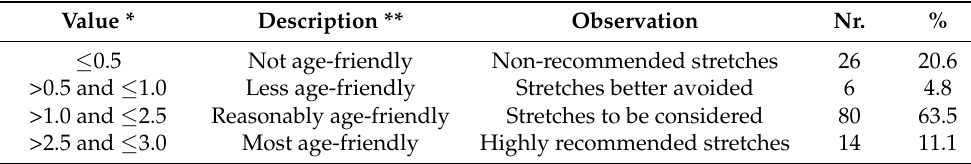
Table 15. Walkability Index for Elderly Health